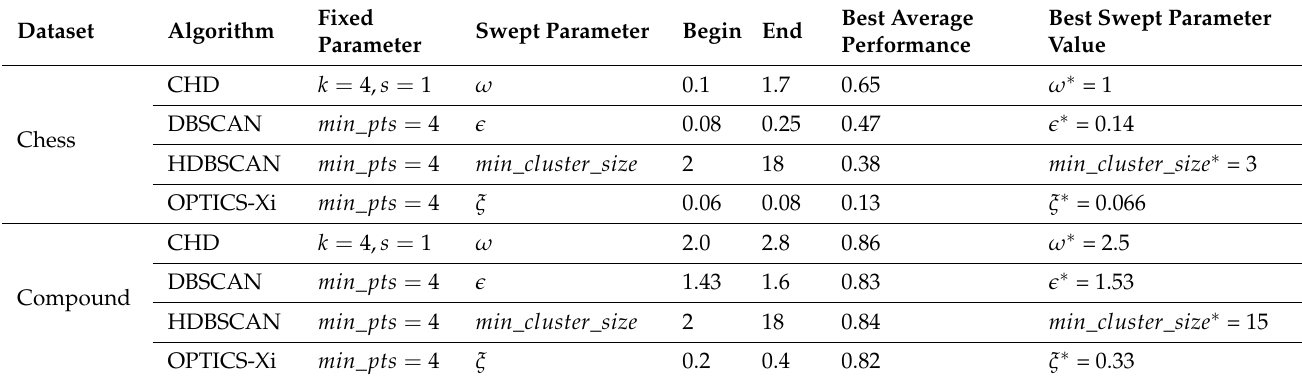
Table 1. Experimental setting for the parameter sweeping for each